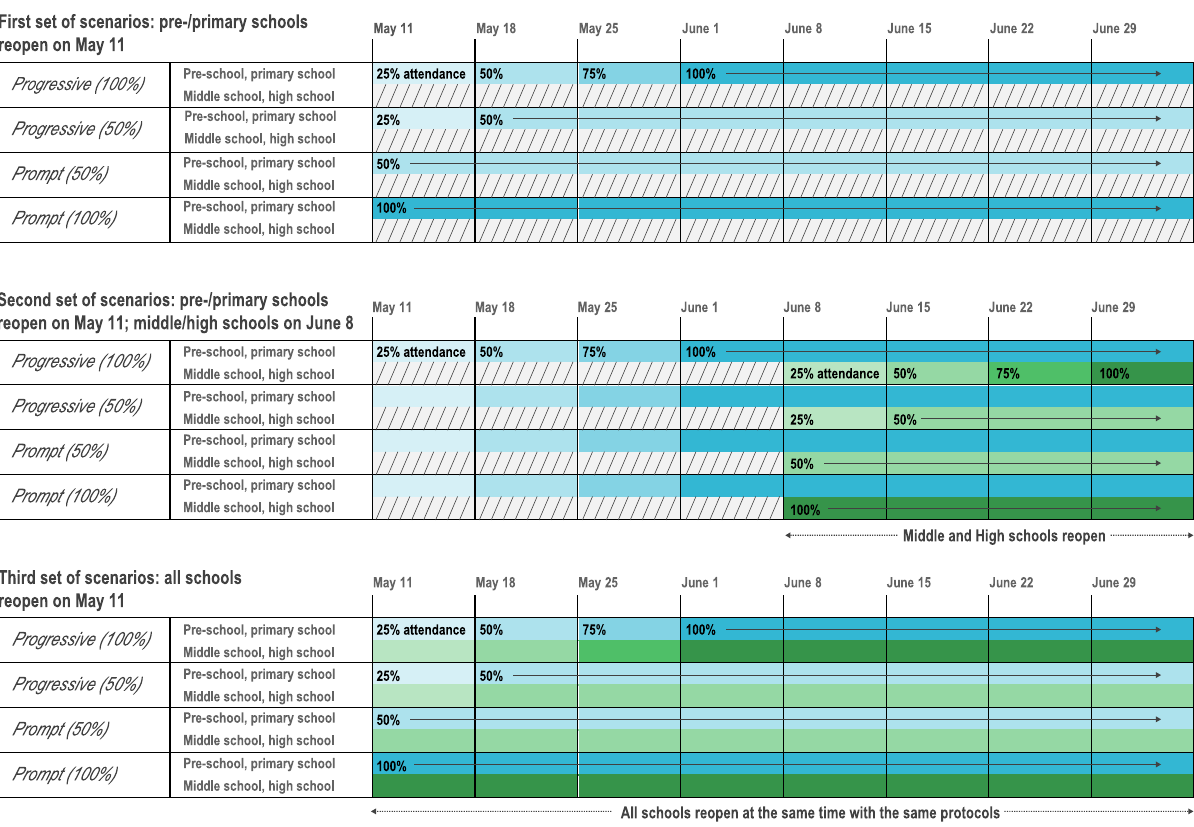
Fig. 2 Protocols of school reopening. The fi rst set of scenarios considers the reopening of pre-schools and primary schools only, on May 11, through Progressive (100%) , Progressive (50%) , Prompt (50%) , and Prompt (100%) protocols. Progressive (100%) : progressive reopening up to 100% attendance, where 25% of students go back to school on the 1st week after lockdown is lifted, 50% on the 2nd, 75% on the 3rd, and 100% from the 4th week till summer holidays. Progressive (50%) : progressive reopening up to 50% attendance, where 25% of students go back to school on the 1st week after lockdown is lifted, and 50% from the 2nd week till summer holidays. Prompt (50%) : partial reopening with 50% attendance from May 11. Prompt (100%) : full reopening with 100% attendance from May 11. Colors indicate school levels (blue for pre-/primary schools, green for middle/high schools). Color gradient indicate student attendance (from lighter to darker, 25% to 100% at 25% incremental steps). The second set of scenarios considers the reopening of pre-schools and primary schools on May 11, only through Progressive (100%) , followed by the reopening of middle and high schools on June 8 through all 4 possible protocols. A sensitivity scenario assuming Prompt (100%) for pre-schools and primary schools is provided in the Supplementary Information. The third set of scenarios considers the reopening of all schools on May 11, with all schools following the same